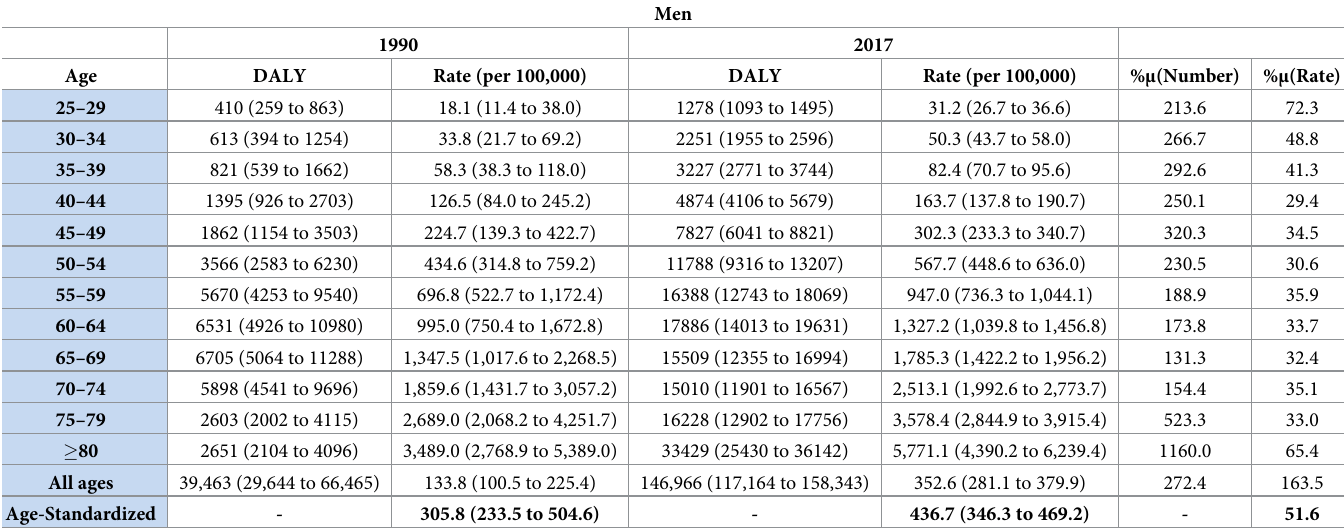
Table 3. DALY number and rate of HHD by age in men in 1990 and 2017 in Iran.